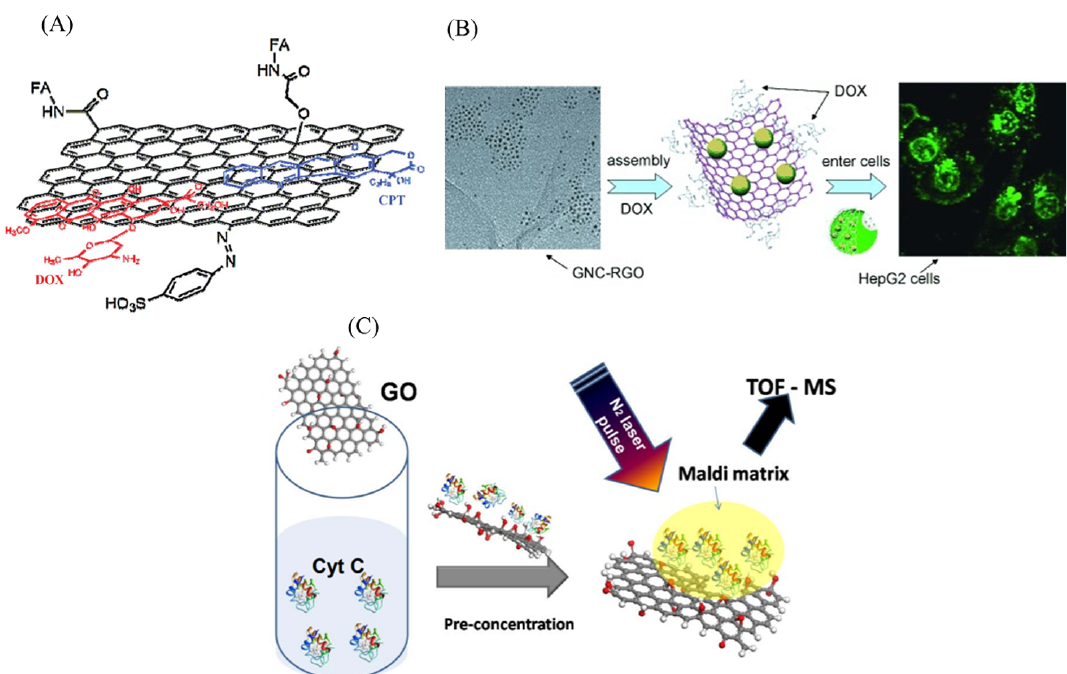
Figure 10. ( A ) Schematic representing the loading of DOX and CPT drugs onto FA-NGO on both sides of the graphene sheets. ( B ) Schematic of gold nanoclusters (GNCs) impregnated onto rGO nanosheets as nanocarrier for doxorubicin (DOX) for the inhibition of HepG2 hepatocarcinoma cells. ( C ) Schematic of GO platform for pre-concentration of Cyt C coupled with MALDI-TOF MS for the detection of (cid:13) Cytochrome C protein solution. Figures reproduced with permission from: ( A ) [159], Wiley c ; ( B ) [160], (cid:13) (cid:13) Wiley online library c ; and ( C ) [163], ACS c